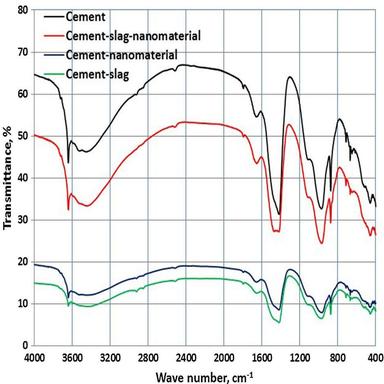
FT-IR spectra of pure cement and cement improved with slag and/or titanate nanofibers.